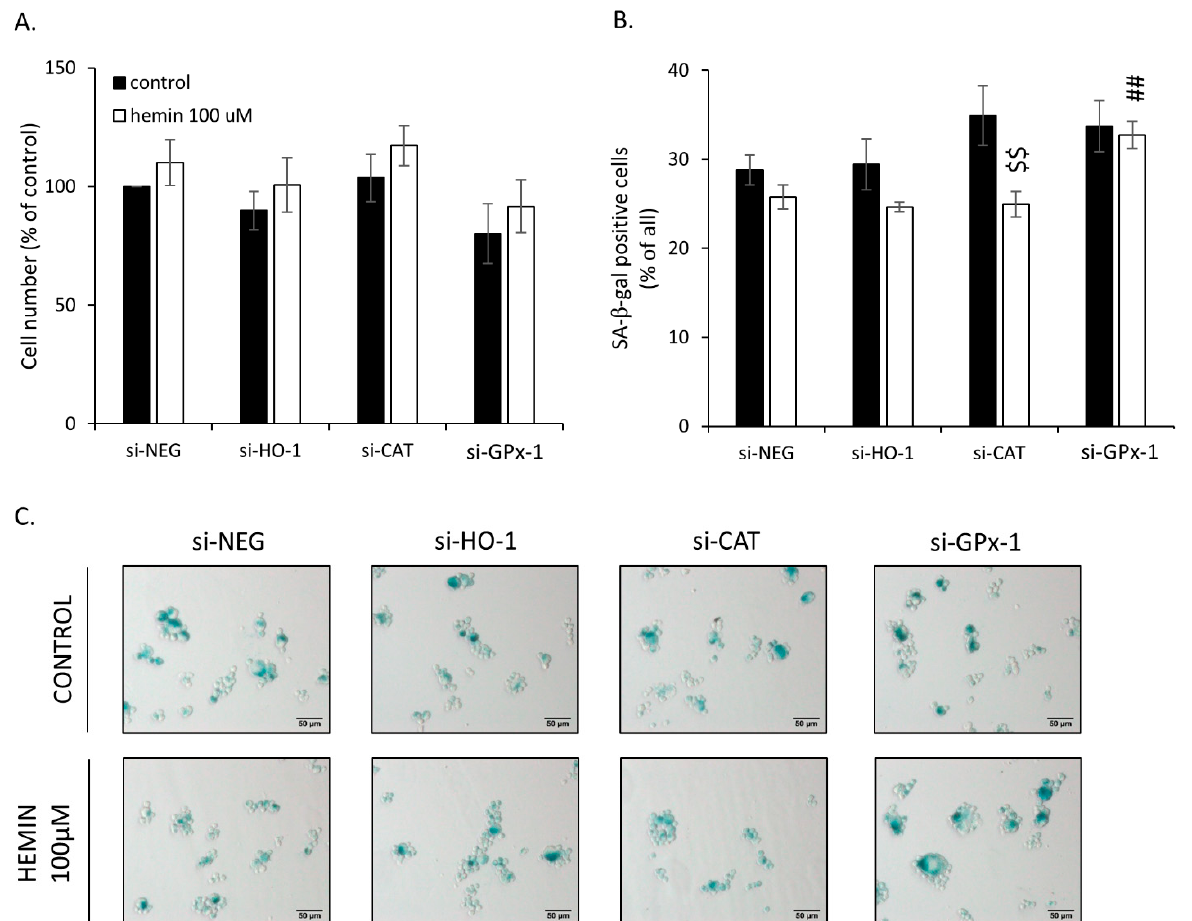
Figure 6. Silencing of antioxidative enzymes maintains colon cancer cells in a senescent state: changed proportion of SA- β -Gal positive cells. In HCT116 cells, genes encoding antioxidative enzymes—HO-1, CAT, or GPx-1—were silenced with the use of siRNAs. Cells were exposed to IRINO and 100 µ M hemin ( (cid:3) ). Control cells were subjected to IRINO and NaOH treatment ( (cid:4) ). Cells were incubated with drugs for 24 h and then cultured in a drug-free medium for 4 days. ( A ) Evaluation of cell number. Cell number was counted with the use of Bürker’s chamber; ( B ) Evaluation of SA- β -gal positive cells. ( C ) Activity of SA- β -gal enzyme. Cells were cytospined and cytochemical stained for SA- β -gal activity. Representative photos were acquired using light microscopy. Original magnification 200 × , scale bar 50 µ M; Each bar represents mean ± SEM, n ≥ 3; ## p < 0.01—vs. si-NEG hemin 100 µ M; $$ p < 0.01—control vs. hemin 100 µ